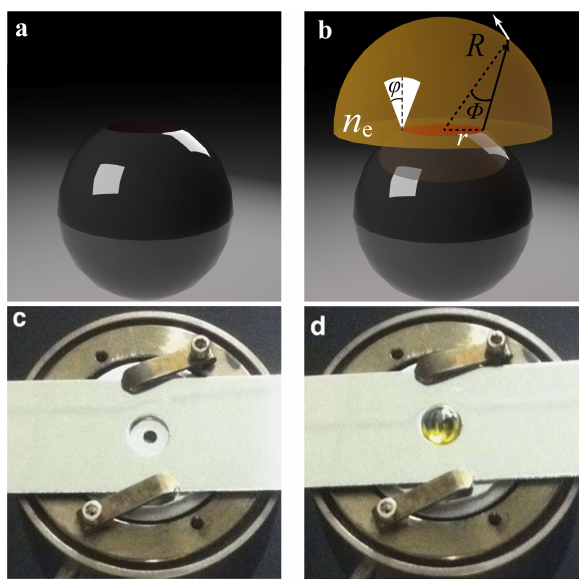
Figure 3: Enhancement of far-field radiation power as a function of the refractive index of the dome n e . Enhancement is compared with σ T 4 S . The structure for enhancement is shown in Fig. 2b. Solid line: Filled cavity with n i = 3 . Dashed line: Empty cavity with n i = 1